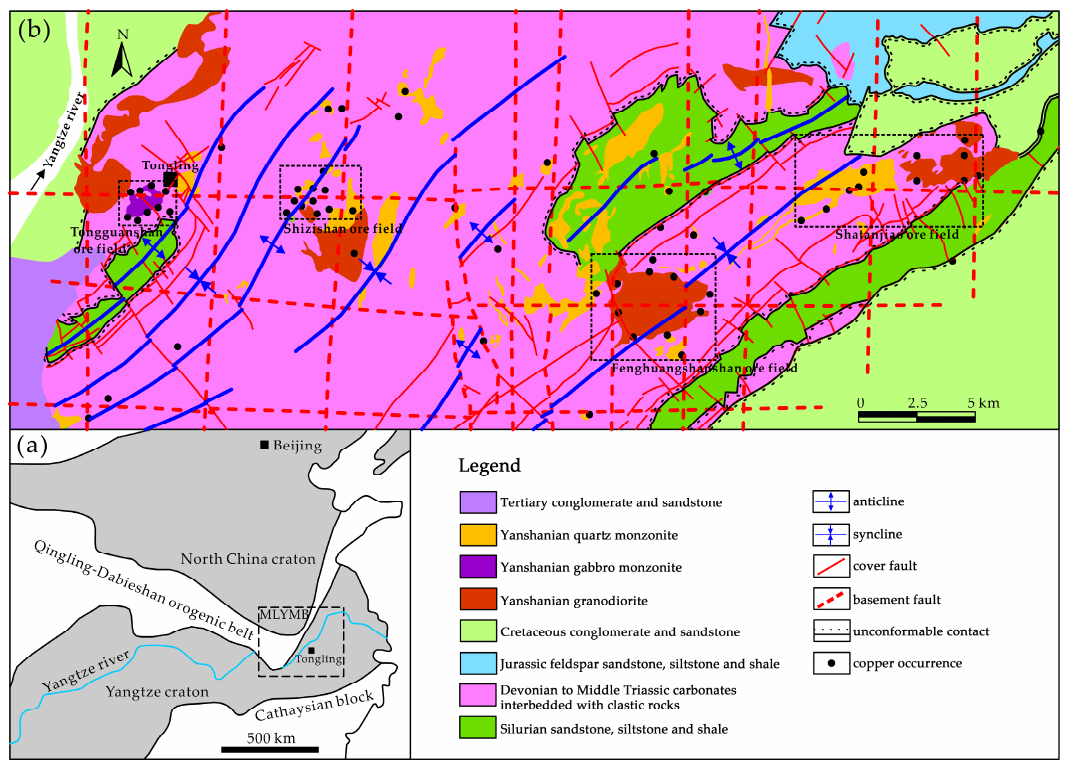
Figure 1. Geological map of the study area: ( a ) simplified tectonic map showing the location of the TOD; and ( b ) geological map of the TOD showing the locations of copper occurrences, modified from a 1:50,000 scale geological map [52] and [37,42,43,53].